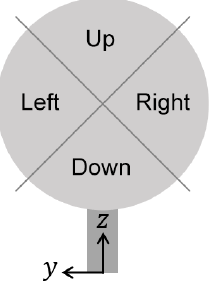
Figure 1. Wind turbine rotor disk with sectors and inflow coordi- nate system. This naming convention is in the downstream viewing